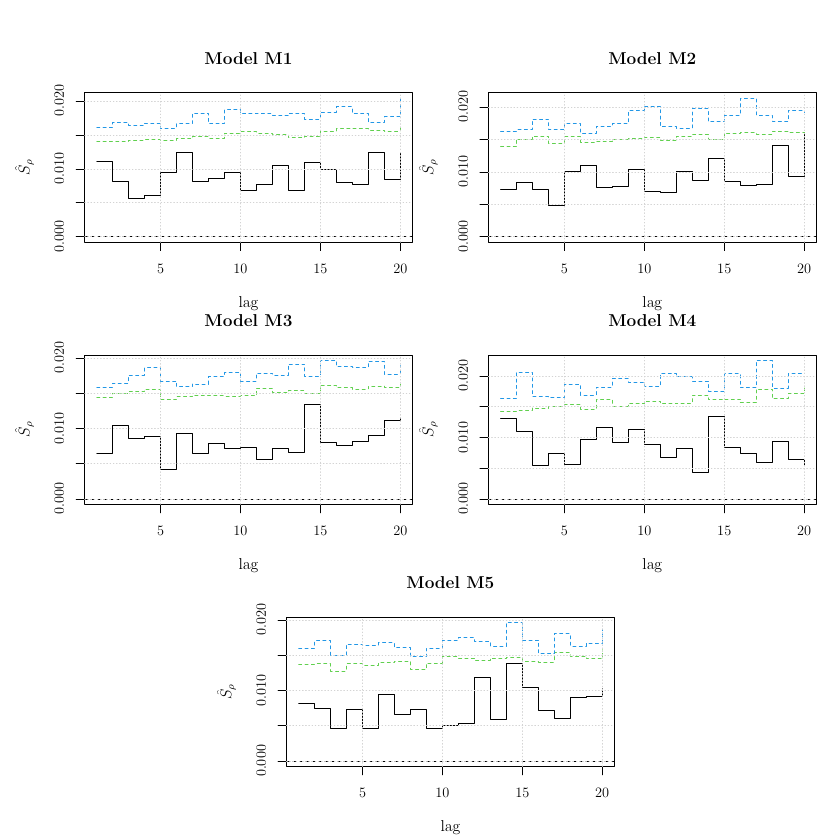
Figure 16 – Entropy measure S ρ computed on the residuals from the TAR models M1 – M5 fit for the time series of the Canadian lynx. The confidence bands at 95% (green) and 99%(blue) correspond to the null hypothesis of serial